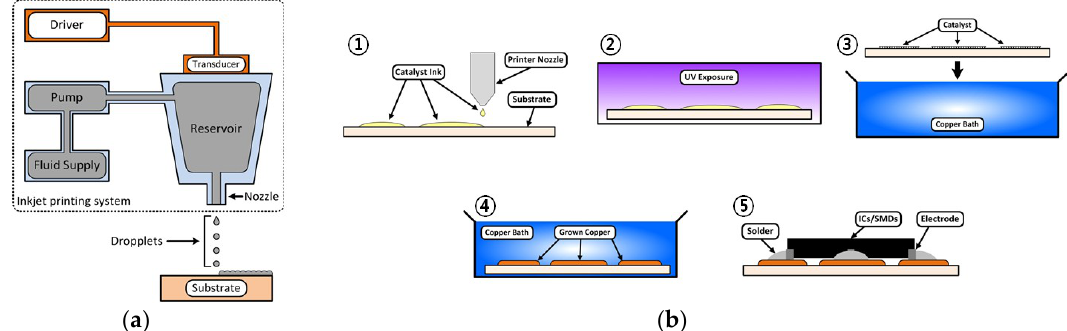
Figure 3. Fabrication process of printed flexible conductive film: ( a ) direct inkjet printing of silver nano-particles and ( b ) indirect printing of thin copper (Cu) film (electroless electroplating).